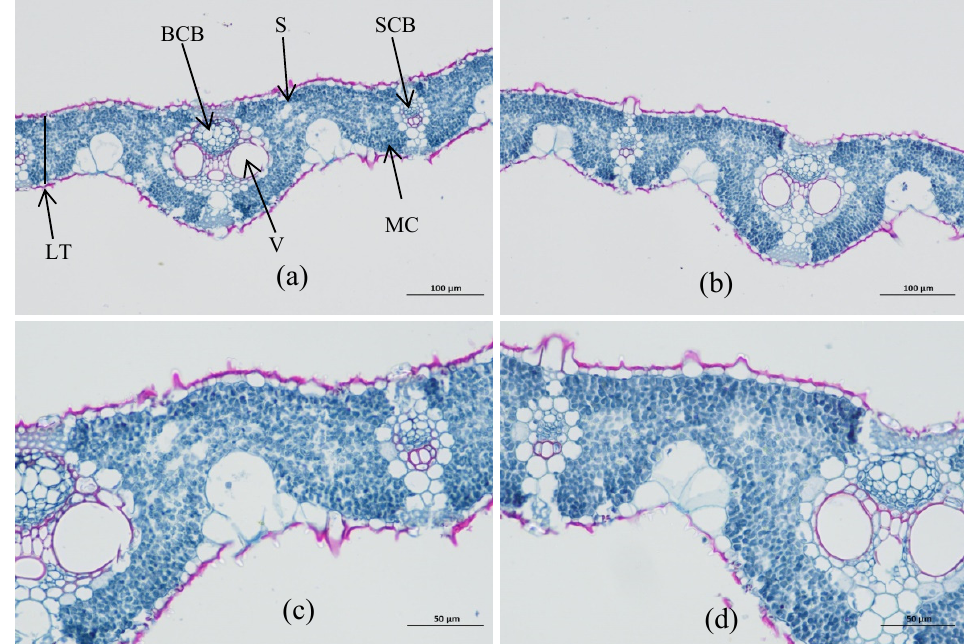
Figure 1. Leaf tissue structure of C1 and G164 rice germplasm resources. Note: ( a , c ) represent C1; ( b , d ) represent G164; BCB: big vascular bundle; SCB: small vascular bundle; LT: leaf thickness; V: vessel; MC: mesophyll cell; S: